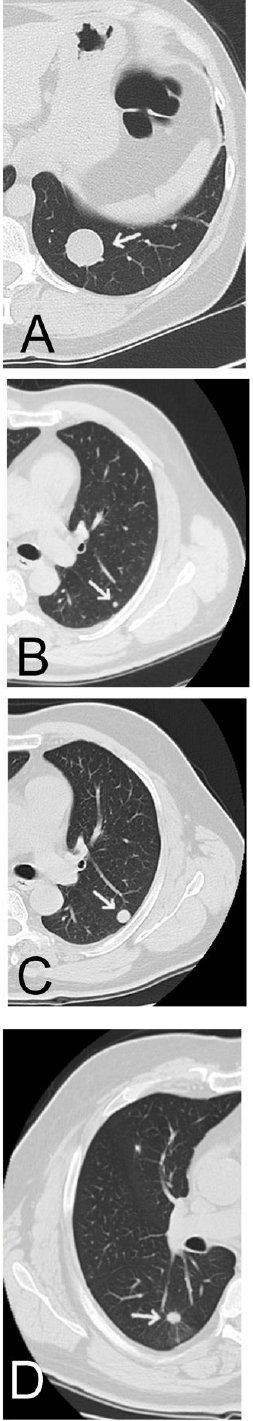
Figure 5. ( A ) The scan shows a malignant 22 mm round-shaped nodule with well-defined margins (arrow) in the left lower lobe in a 44-year-old female patient with synovial sarcoma. ( B ) The scan shows a 3 mm subpleural round nodule with well-defined margins (arrow) at baseline CT. ( C ) Preoperative CT scan obtained approximately 3 months later in the same patients showing a significant increase in size (11 mm, arrow). The patient received no chemotherapy between the scans. ( D) The scan shows a 10 mm malignant parenchymal nodule with an irregular shape and spiculation (arrow) in the right lower lobe in a 52-year-old male patient with undi ff erentiated spindle-cell